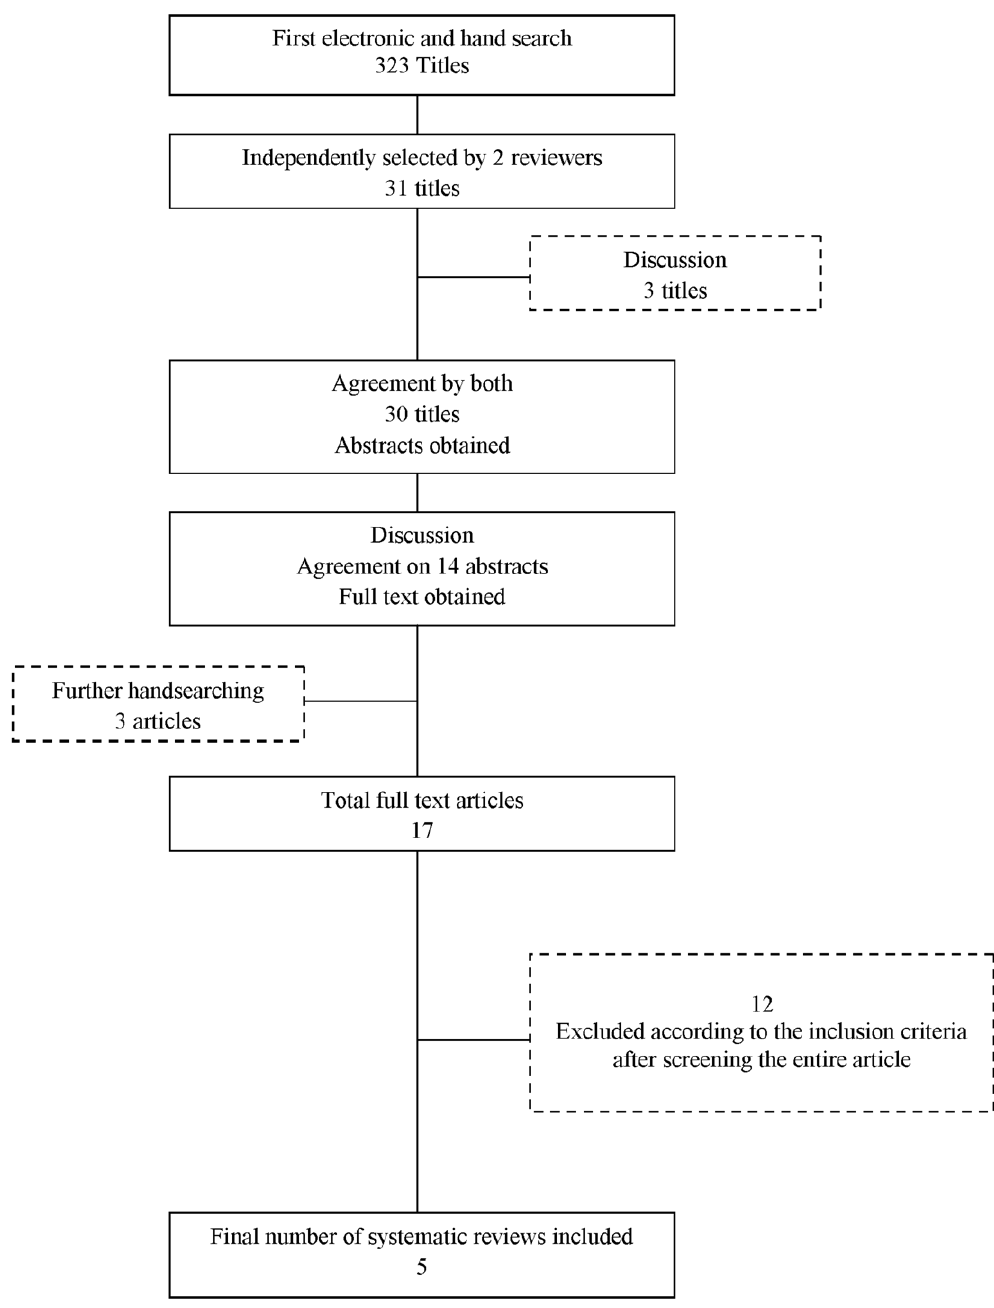
Figure 1. Flowchart of systematic review selection.